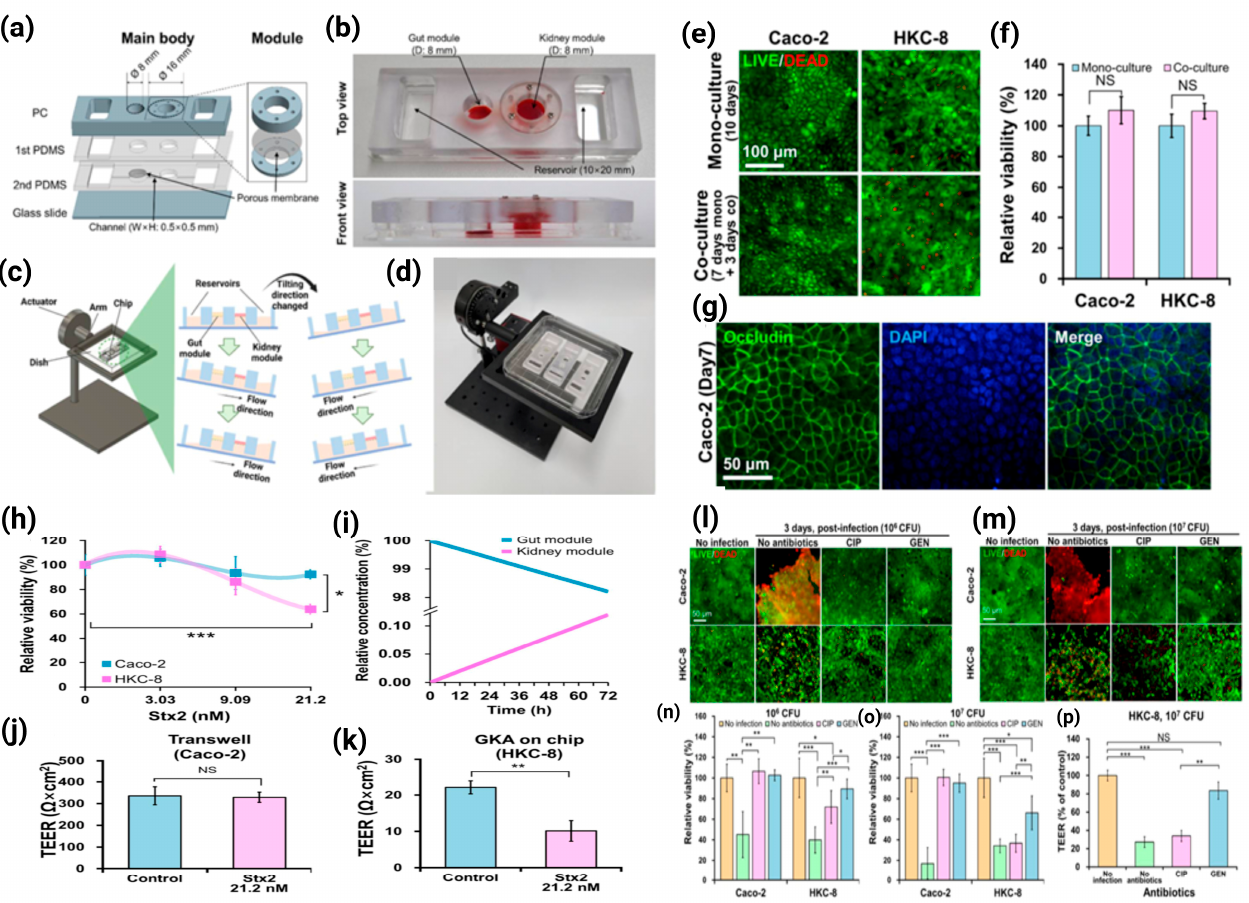
Figure 10. GKA on chip for studying effects of antibiotics on risk of hemolytic uremic syndrome by Shiga toxin-producing Escherichia coli. ( a ) Assembly of a main body in four layers with modules. ( b ) View of completed GKA on chip showing gut and kidney modules and two reservoirs. ( c ) Gravity- induced perfusion by periodically tilting the chip 10 degrees (0.1 degree/s) every 10 min. ( d ) View of the tilting machine inducing gravity-driven perfusion of cell culture medium in GKA on chip. ( e ) LIVE/DEAD stained images and ( f ) EZ-CytoX assay of Caco-2 and HKC-8 cells either mono-cul- tured or co-cultured for 3 days. ( g ) Immunostaining of occludin in Caco-2 cells at day 7. ( h ) Viabili- ties of Caco-2 and HKC-8 cells to Stx2 in GKA on chip. Only the gut module was treated with the toxin at different concentrations (0–21.2 nM) for 72 h. ( i ) Simulation of Stx2 transport from the gut module to the kidney module in the Experimental Section. ( j ) TEER Value of Caco-2 cells to Stx2 at 21.2 nM in Transwell for 72 h. ( k ) TEER values of HKC-8 cells after treatment with 21.2 nM of Stx2